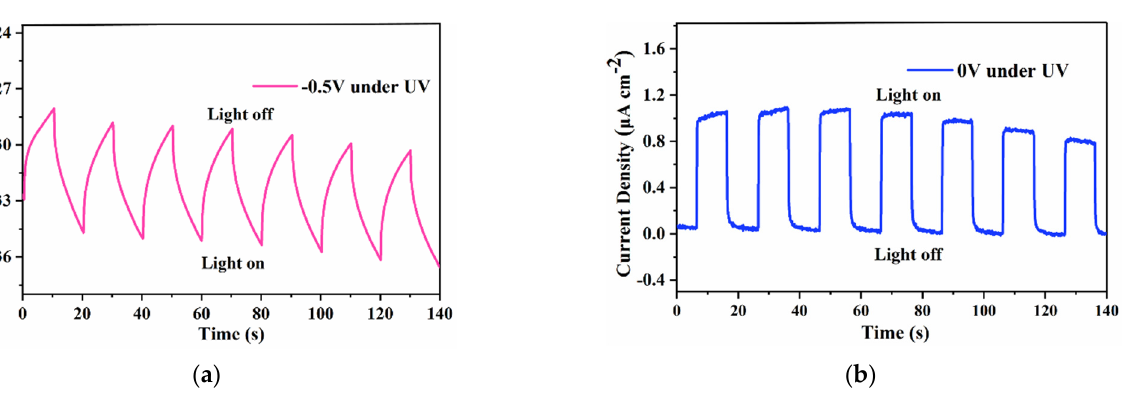
Figure 5. Transient photocurrent/time profiles of the bare glassy carbon electrode and 1 , which were coated on the glassy carbon electrode in a KCl electrolyte (0.1 mol·L − 1 ) at a bias of − 0.5V ( a ) and 0.0V ( b ), with and without light irradiation.